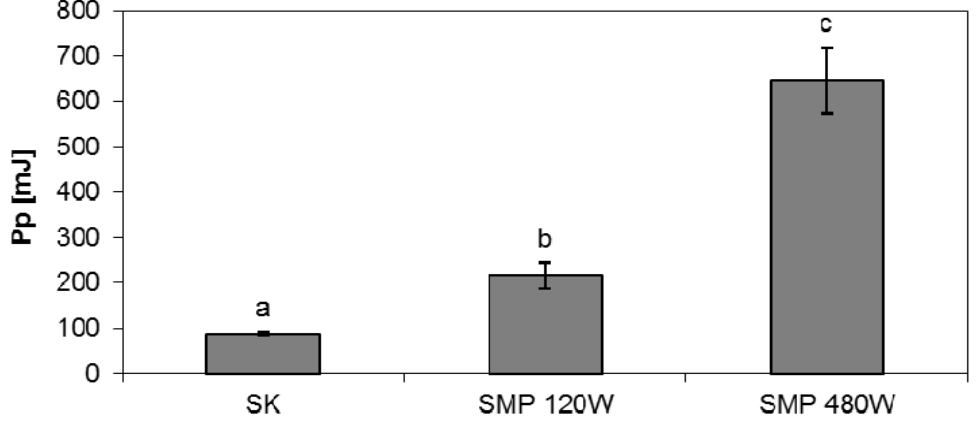
Figure 2. Values of work needed to cut the dried Physalis. SK—convective method; SMP—microwave method under reduced pressure 120 W and 480 W; Mean values with different letters (a, b, c) within the same columns are statistically different ( p = 0.05).